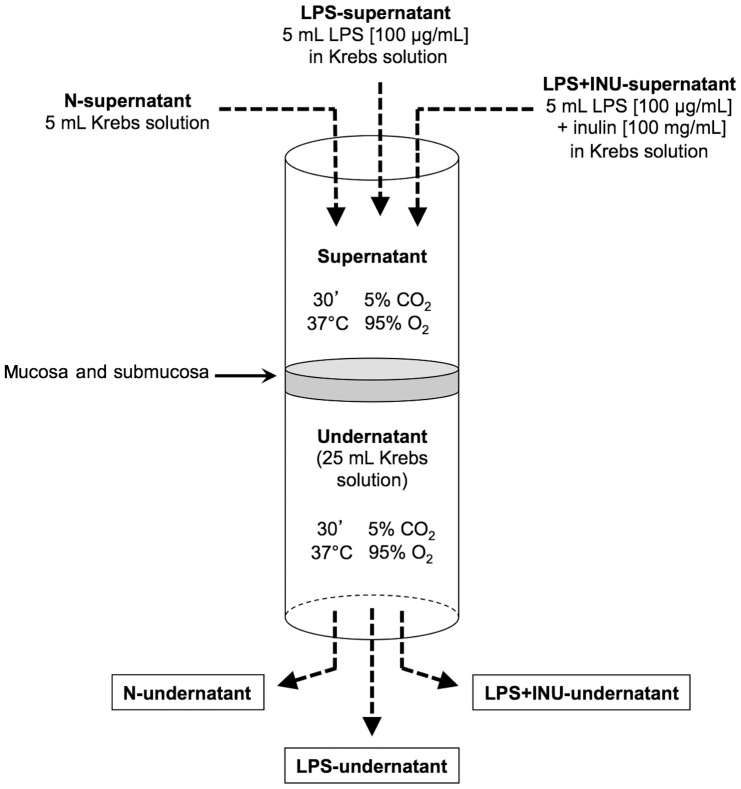
Schematic representation of the experimental set-up.